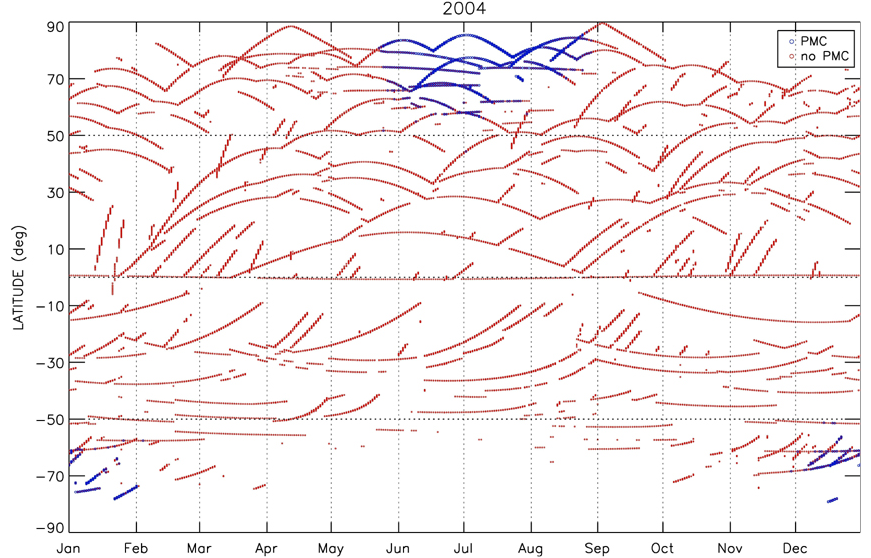
Fig. 46. Latitude-time plot of all day-side occultation points during the year 2004. In red are marked the points where no PMC is seen, while in blue are the points with a PMC detected. The seasonal behavior is well marked. The coverage is somewhat poorer in the south, but still PMCs are less frequent in the South than in the North.